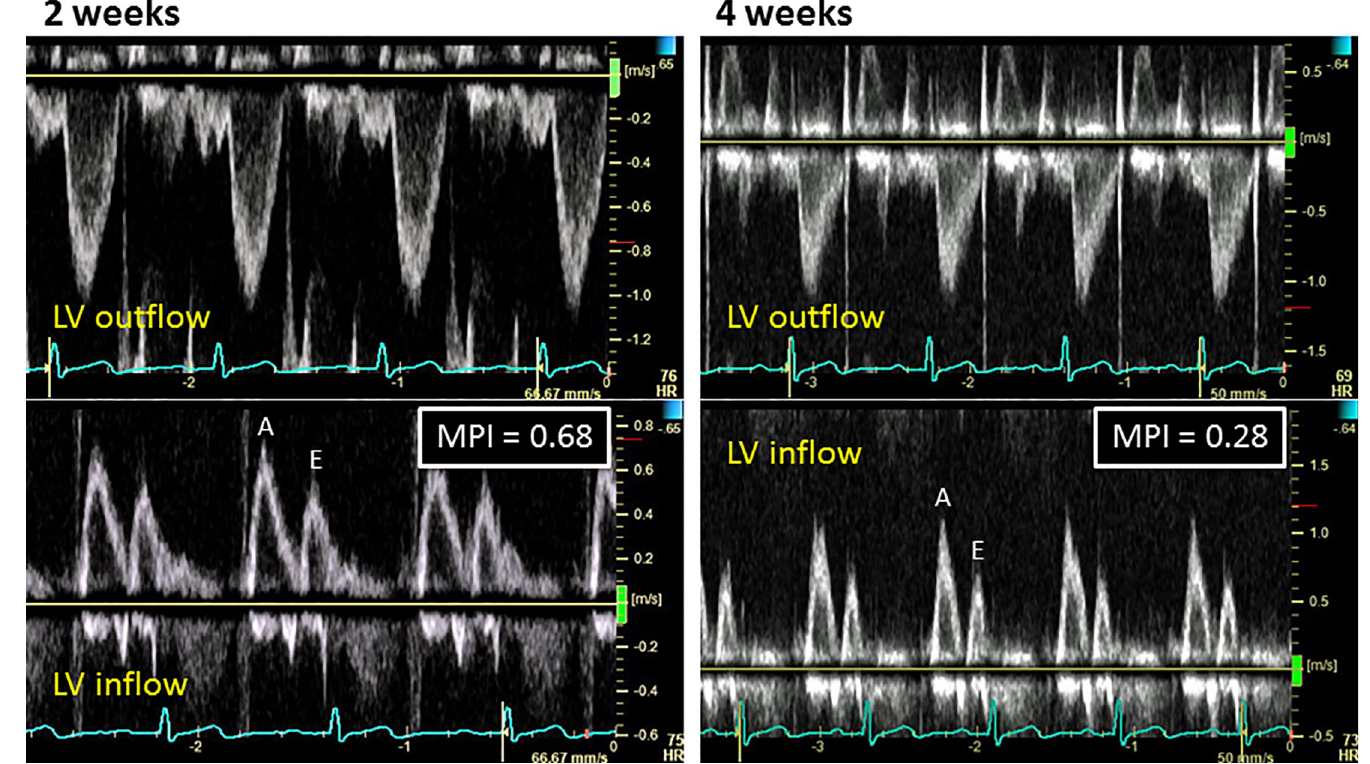
Fig 3. Doppler LV outflow (top) and inflow (bottom) profiles used to measure MPI at 2 and 4 weeks after diagnosis of IVI in a woman aged 42